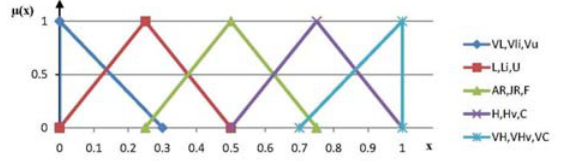
Figure 4. Triangular fuzzy numbers for linguistic